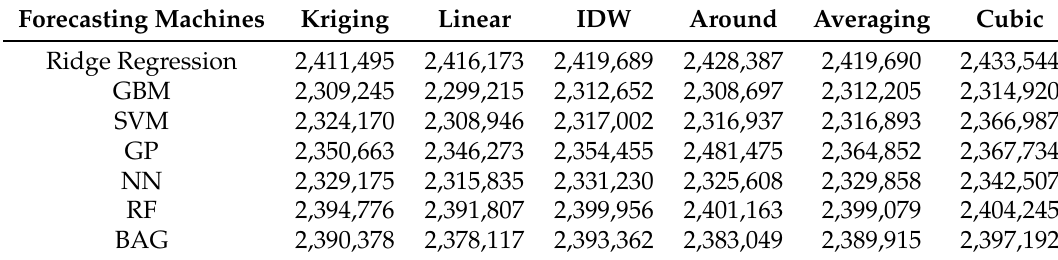
Table 1. The performance of various interpolation functions is measured by the MAE (mean absolute error) in Wh/m 2